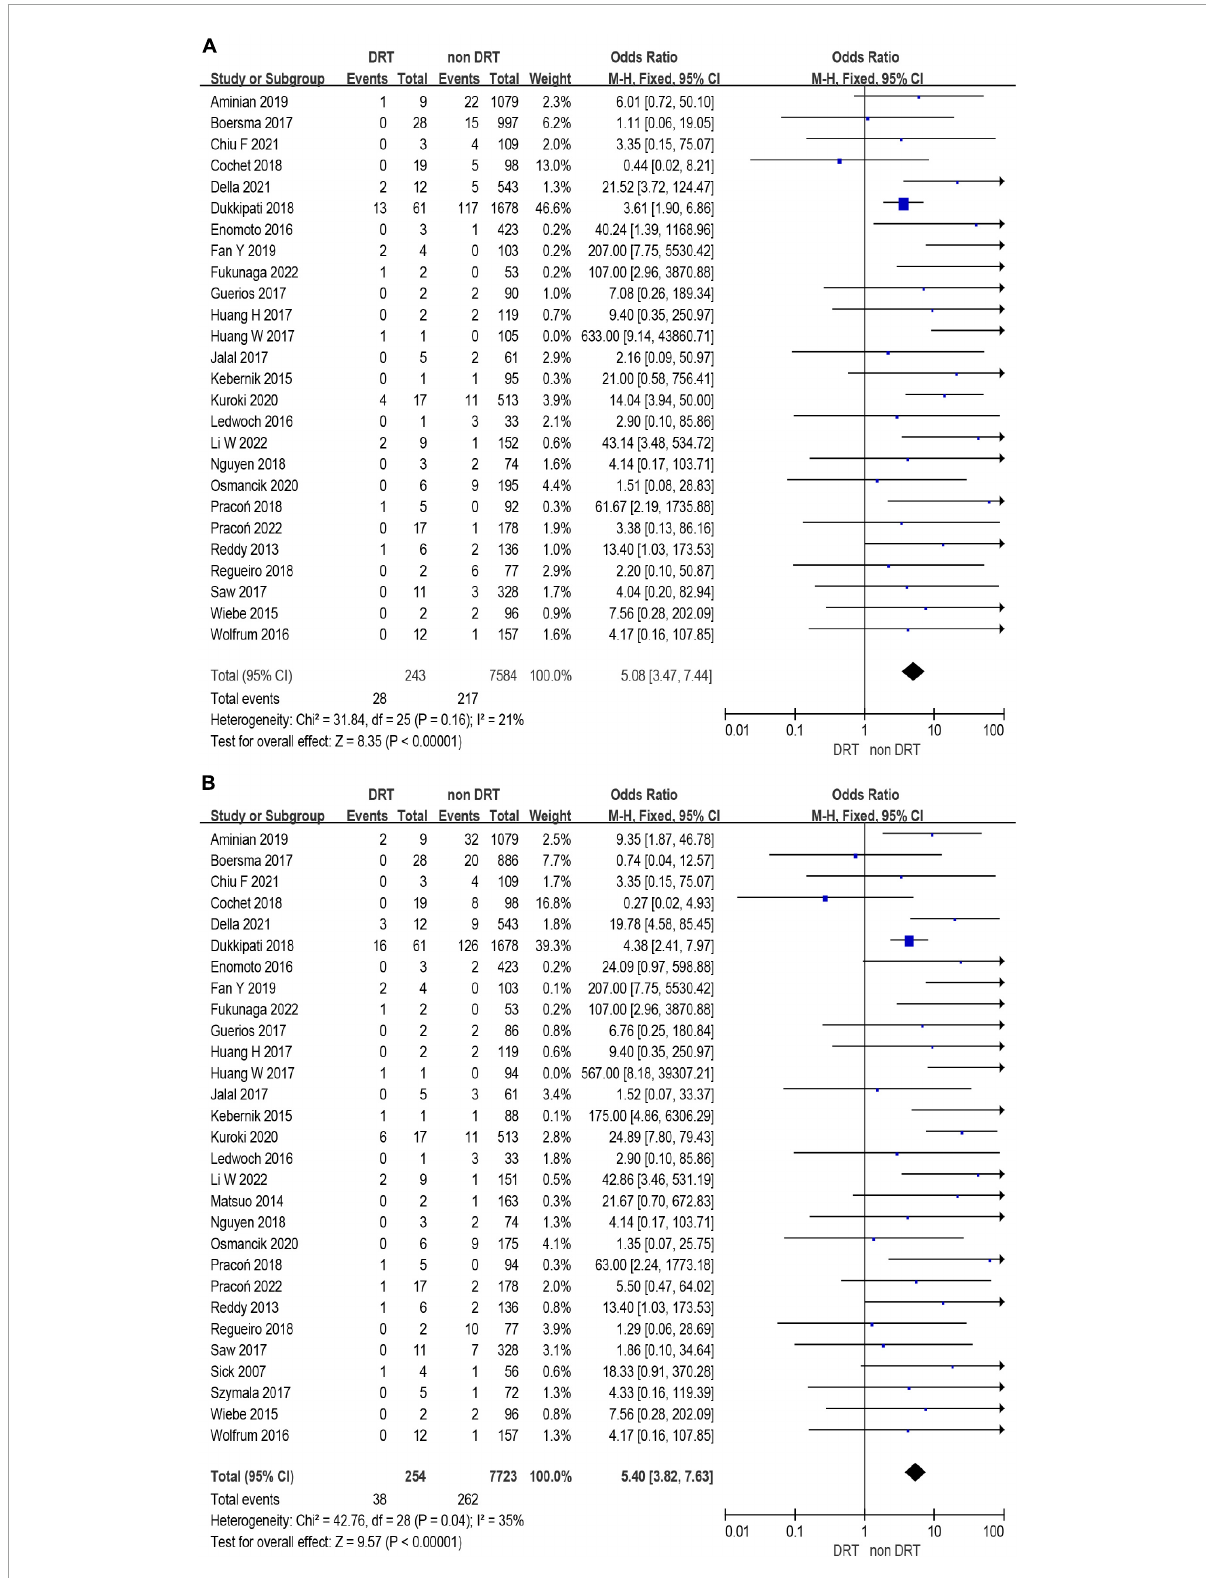
FIGURE3 Forest plots of stroke (A) and systemic embolism (SE) (B) in patients with device related thrombus (DRT) and